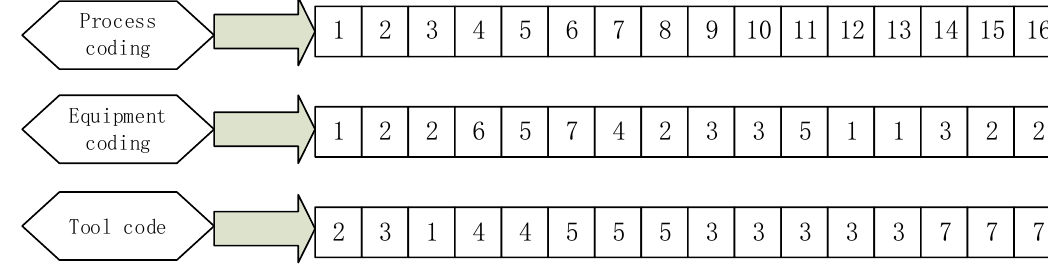
Figure 4. Coding